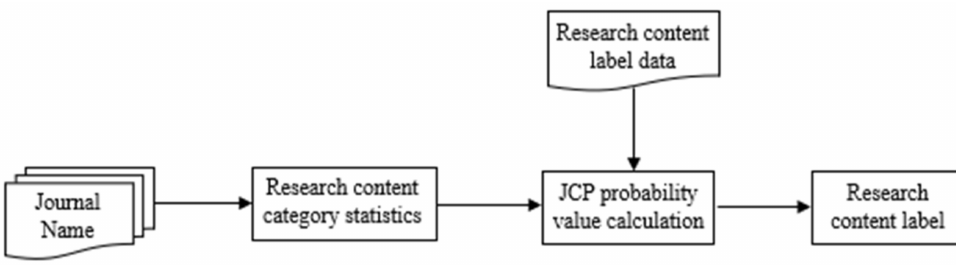
Figure 3. Journal features mapping